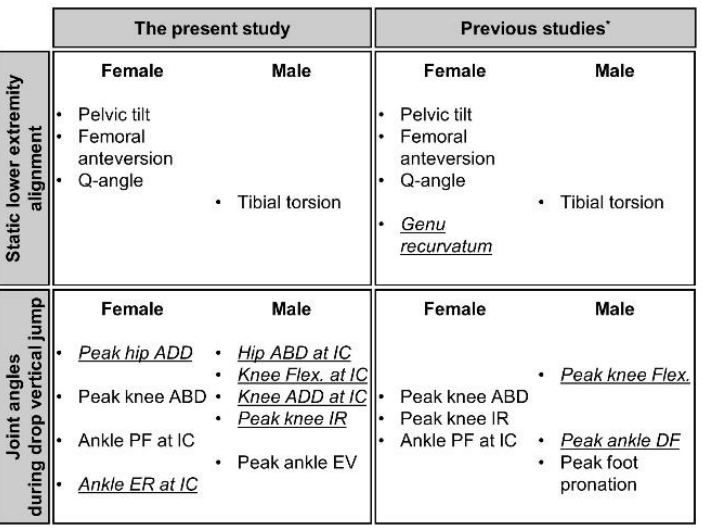
Figure 4. The comparisons of major findings of this study with previously reported differences in lower extremity alignments (LEAs) and lower extremity kinematics (LEKs) during landing activi- ties between males and females. The italic and underlined variables are the disagreement between Table 7. were cited. Note. ABD: abduction; ADD: adduction; Flex: Flexion; IR: internal rotation; PF: plantarflexion; DF: dorsiflexion; EV: eversion; ER: external rotation; IC: initial